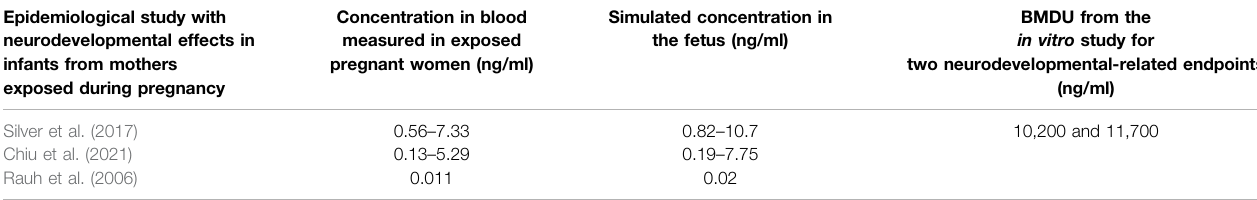
Concentration in blood measured in